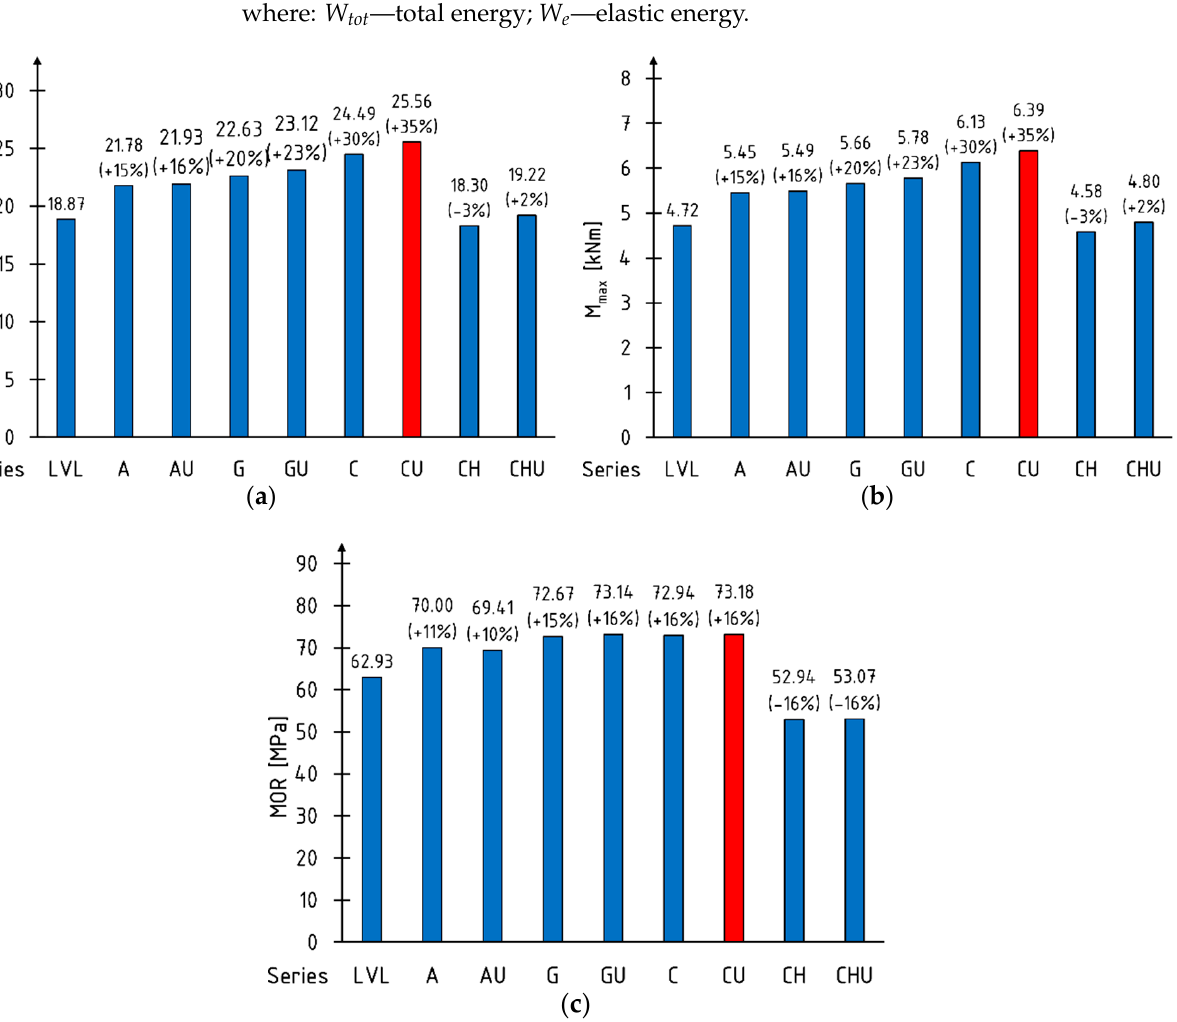
Figure 5. Load bearing capacity: ( a ) maximum loading force; ( b ) maximum bending moment; ( c ) modulus of rupture.